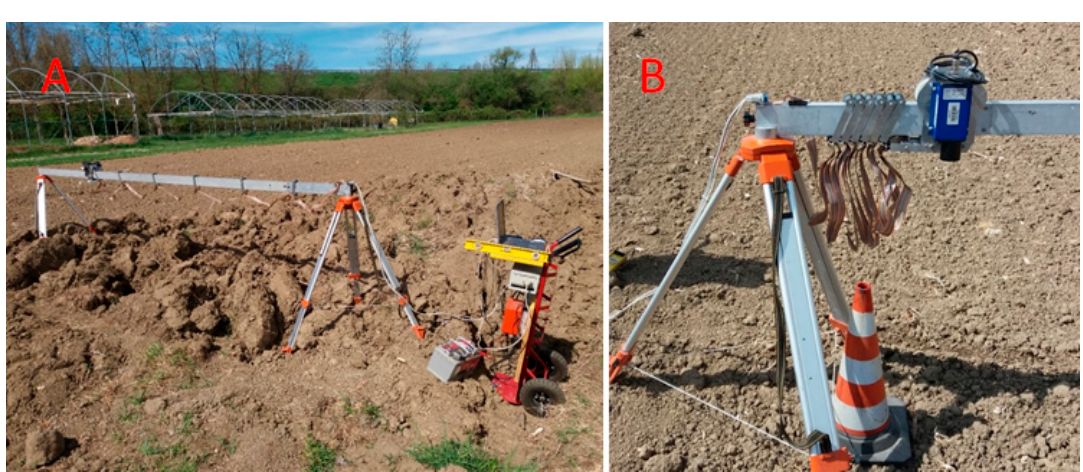
Figure 1. ( A ) Laser microreliefmeter used for determining the surface roughness. On the left the supply and control unit. ( B ) View of the laser sensor moving on a metallic rail.